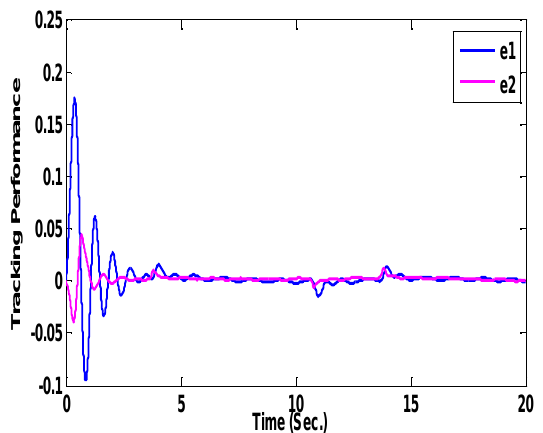
Figure 10. Tracking performance under disturbance.